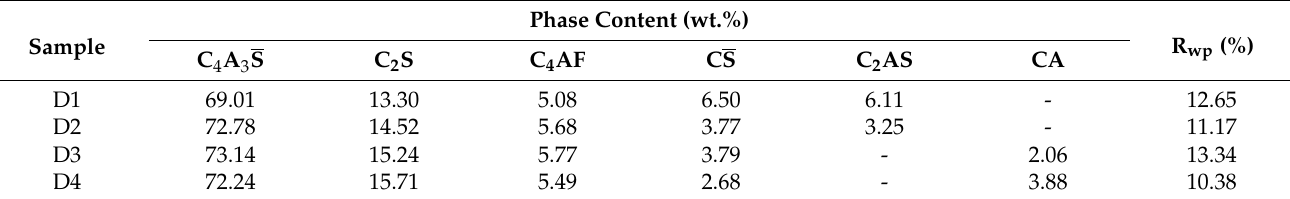
Table 7. Contents of S2 samples fired at different times (wt.%).